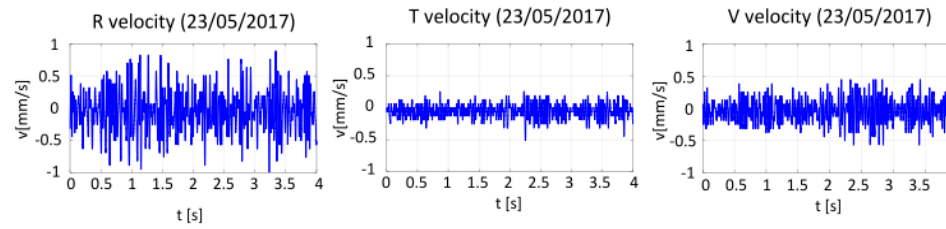
Figure 7. Radial ( R ), Transversal ( T ) and Vertical ( V ) velocity time-histories recorded by geophone “GSM 4279” during TBM tunnelling at 00:39 (Italian time) on 23 May 2017 (see Figure 6).